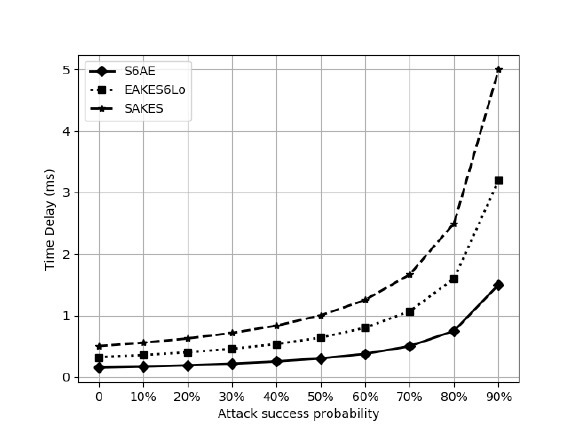
Figure 6. Computational